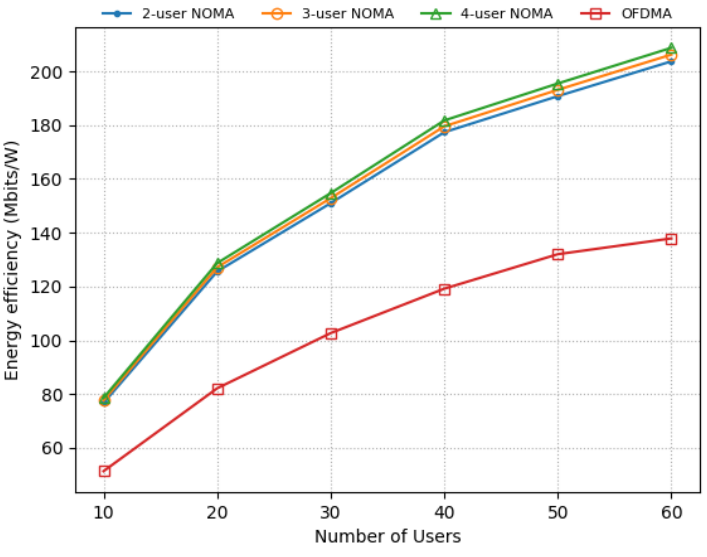
Figure 3. Energy efficiency versus different number of users for NOMA and OFDMA based systems. Table 1. Simulation parameters for downlink NOMA systems.